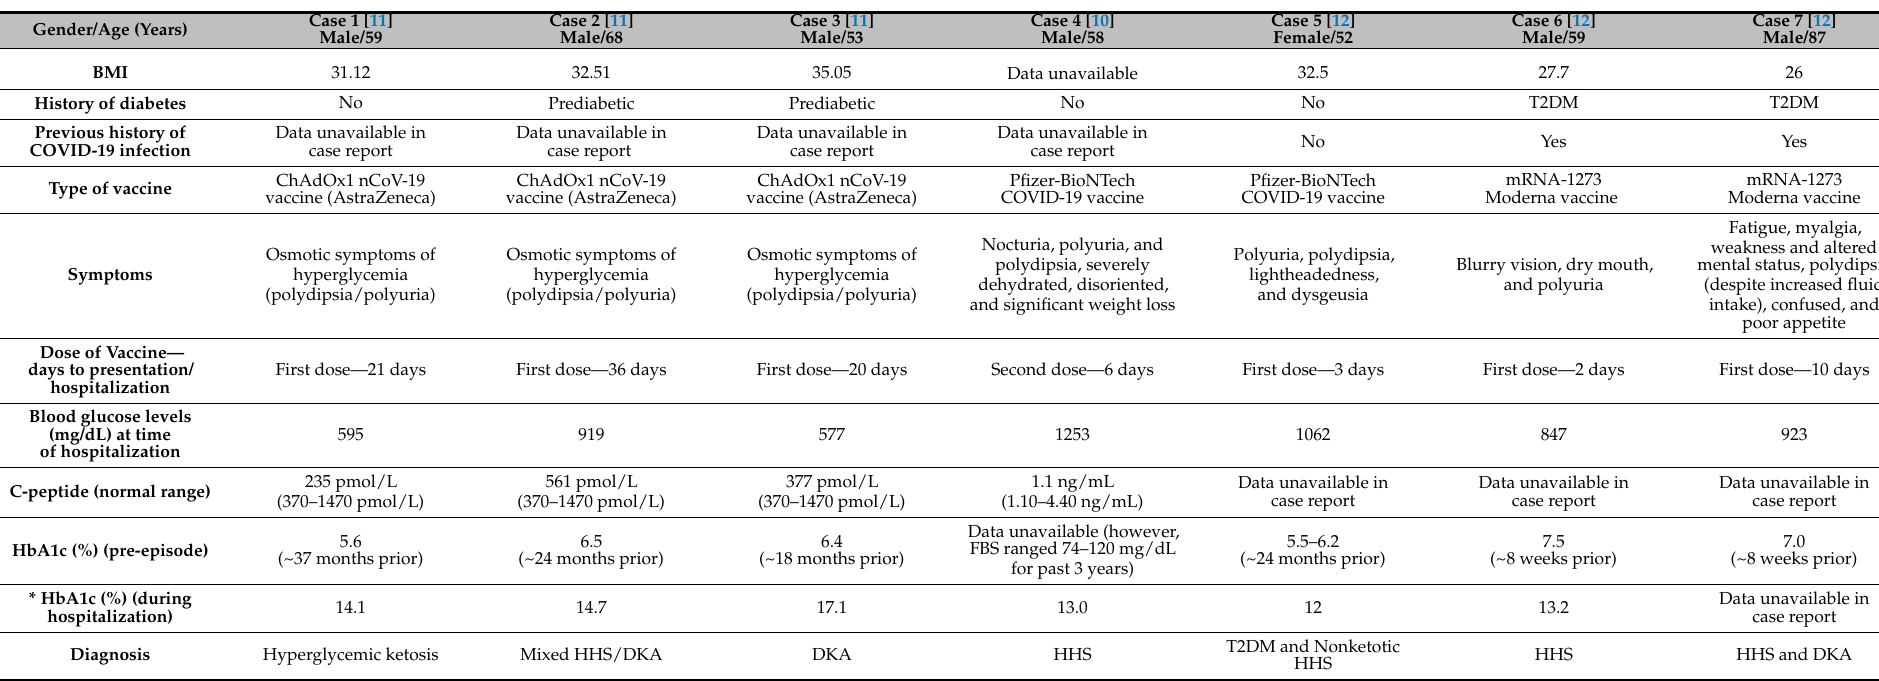
Table 1. Published case reports of possible COVID-19 vaccination associated with hyperglycemia and hyperglycemic